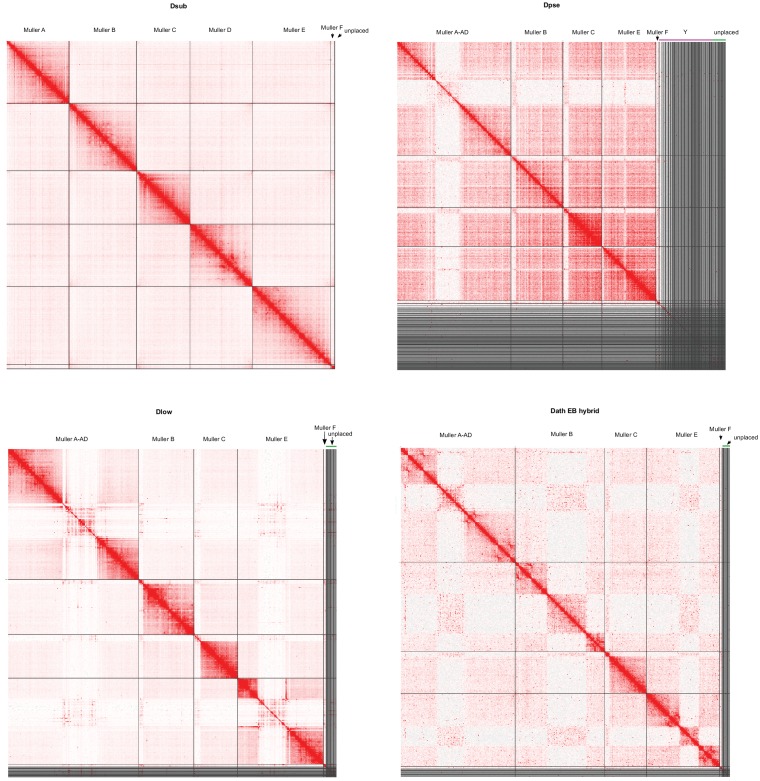
Hi-C association heatmaps of genome assemblies for D. subobscura, D pseudoobscura, D. lowei and D. athabasca.Lines demarcate assembled chromosomes and unplaced or Y contigs. Note that pericentromeric regions typically show weak Hi-C associations with neighboring euchromatic regions due to their repetitiveness, thus producing ‘checkerboard’ patterns in the plot. Also of note, off-diagonal associations are apparent in many euchromatic arms in our hybrid D. athabasca assembly and thus identify chromosomal inversions (see Materials and methods).